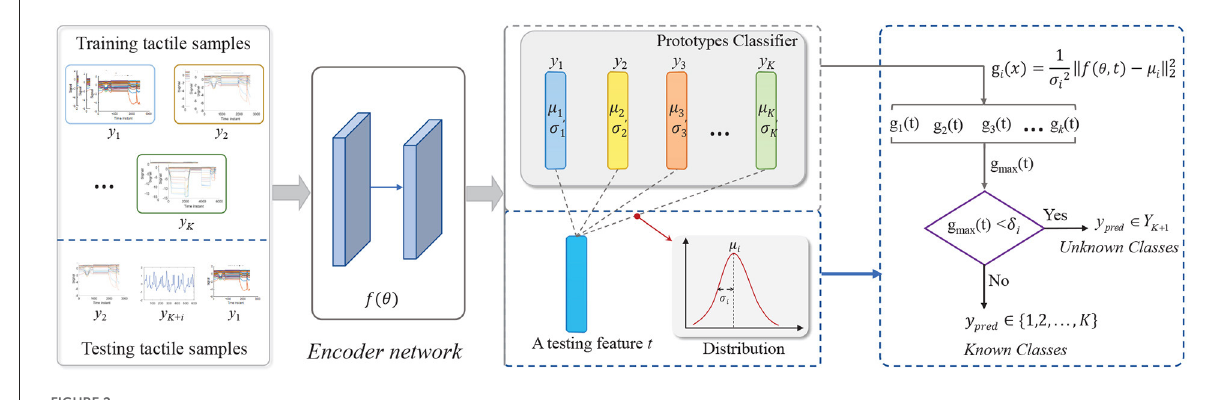
FIGURE2 The framework of our proposed method for open-set